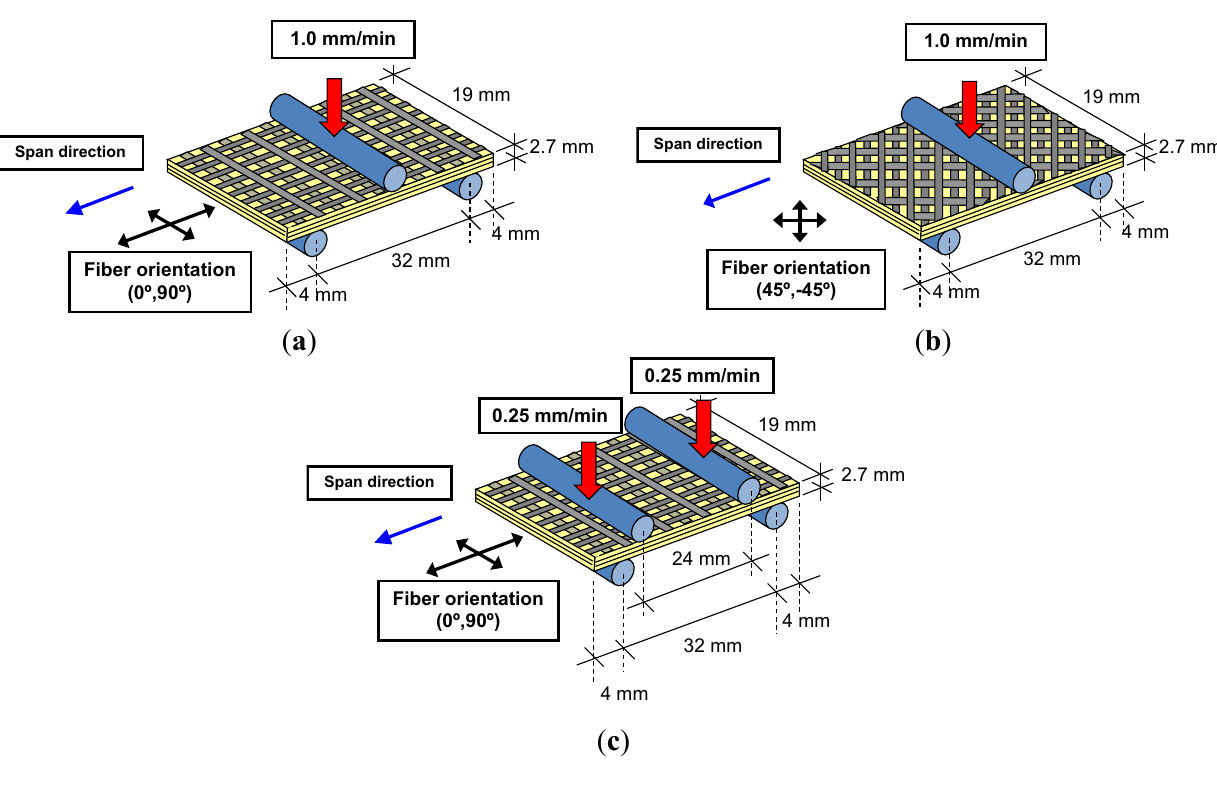
Figure 3. on- and off-axis arrangements for a flexure test: ( a ) on-axis flexure test; ( b ) off-axis flexure test; ( c ) on-axis shear